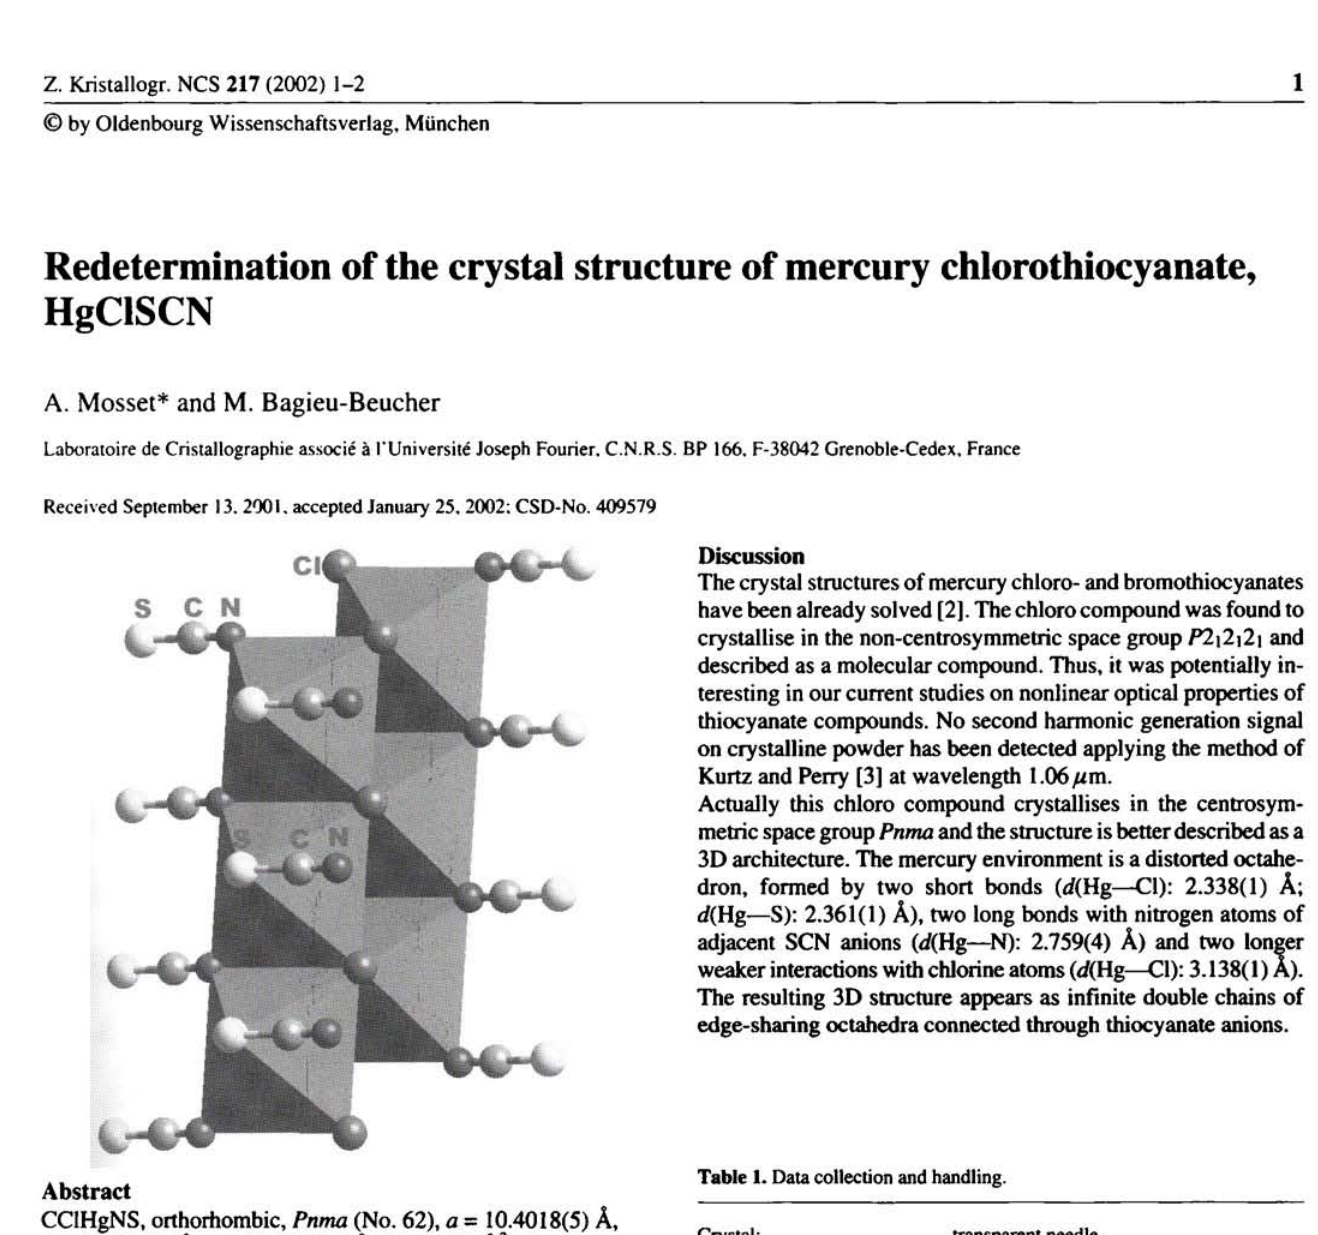
Table 2. Atomic coordinates and displacement parameters (in Â 2